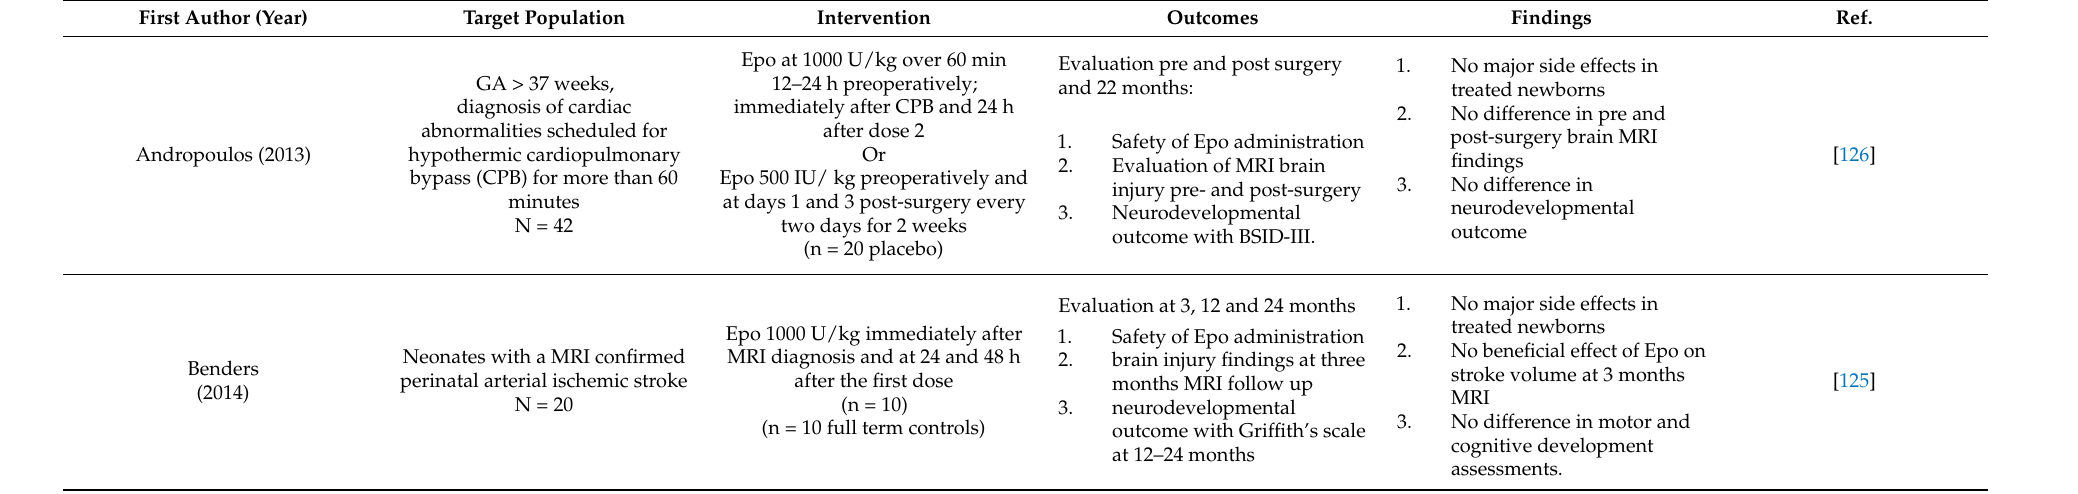
Table 3. Results of Erythropoietin (Epo) administration in neonatal